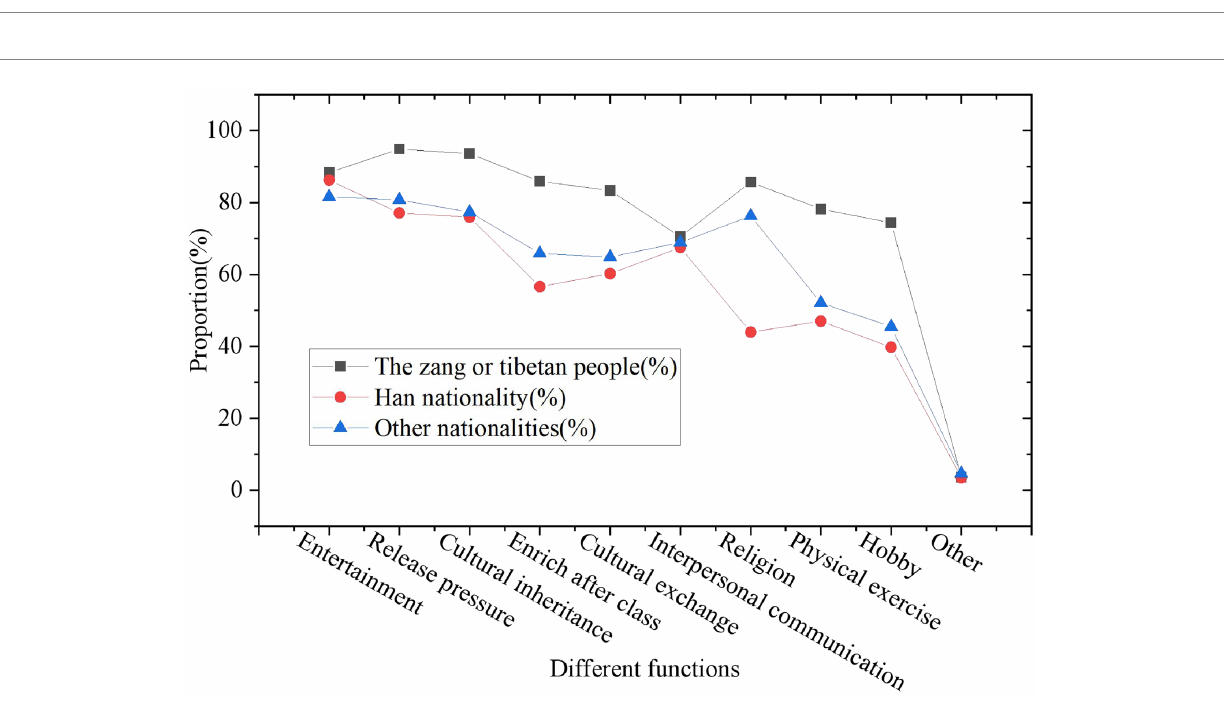
FIGURE 7 Student’s functional cognition survey on folk music and dance (statistics by gender).